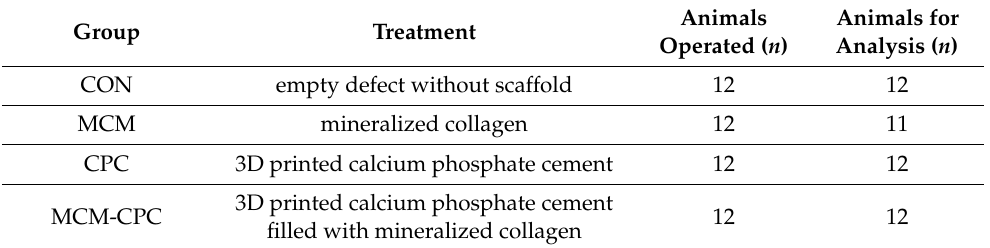
Table 1. Study overview including treatment groups and sample